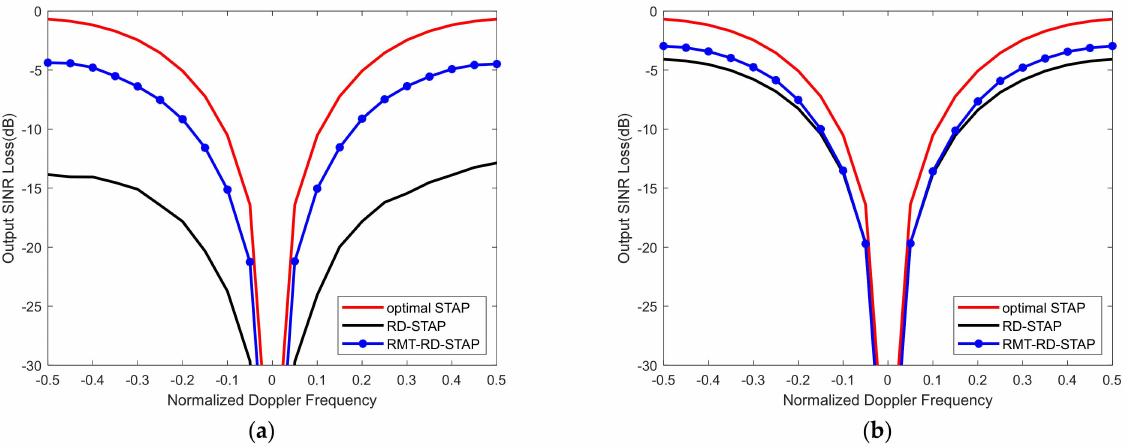
Figure 6. Output SINR losses versus normalized Doppler frequencies with V = 300 m/s. ( a ) L = M training samples and ( b ) L = 2 M training